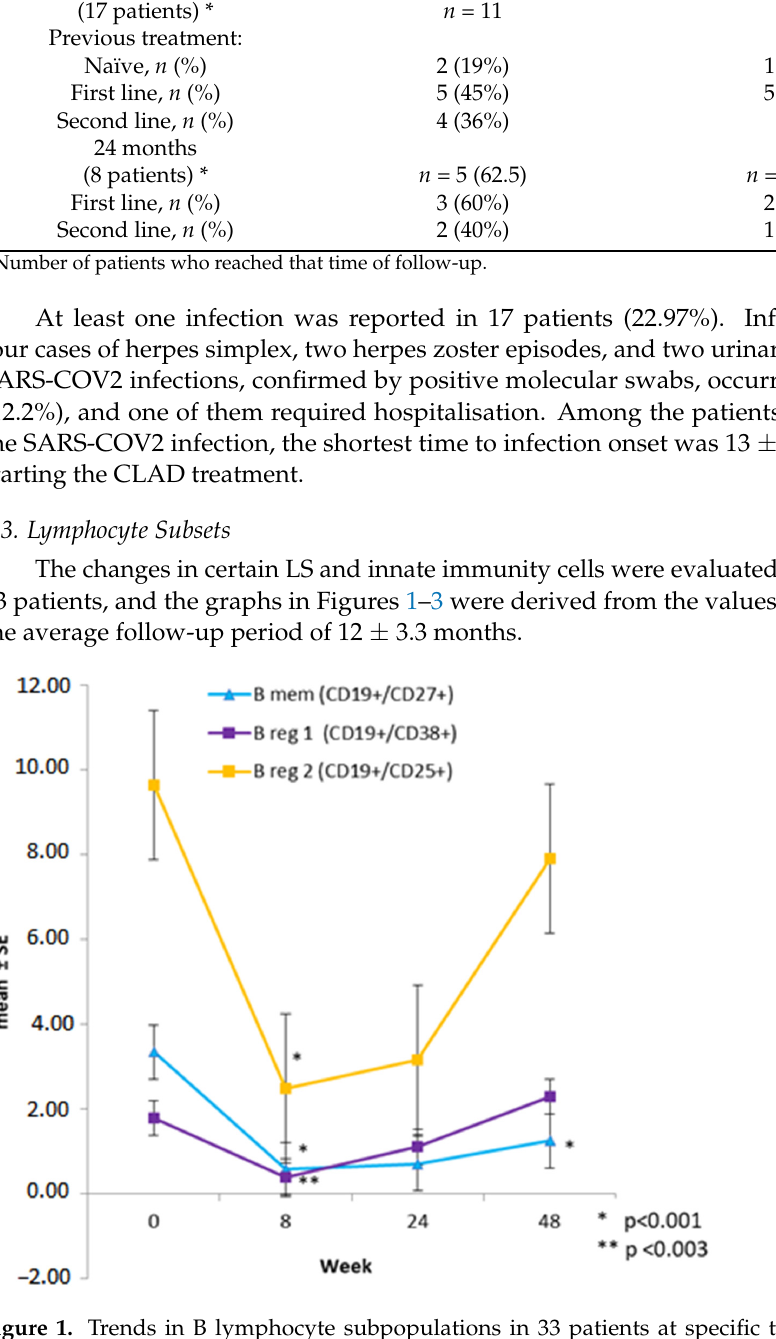
Figure 1. Trends in B lymphocyte subpopulations in 33 patients at specific times after starting cladribine therapy; generalised linear mixed model (* p < 0.001 and ** p < 0.003). The T LS responded differently. There was a significant increase of 54.2% in Treg